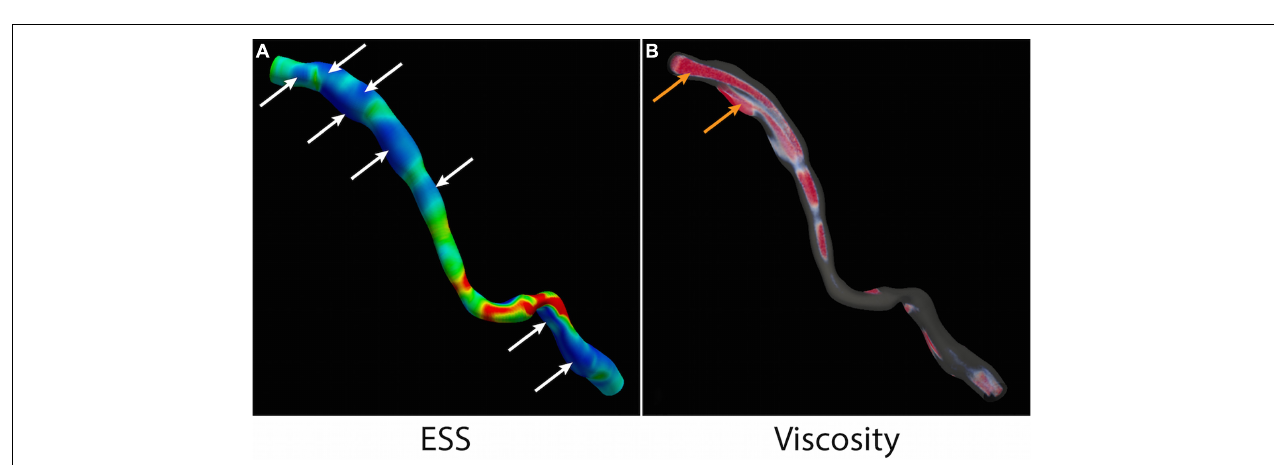
FIGURE 5 | ESS and local blood viscosity. (A) Multiple areas of low ESS ( < 1Pa) are identified (white arrows). (B) Non-Newtonian simulation detects regions of high LBV ( > 1.45) in the centre of the vessel and at the wall (orange arrows). ESS, endothelial shear stress; LBV, local blood viscosity.